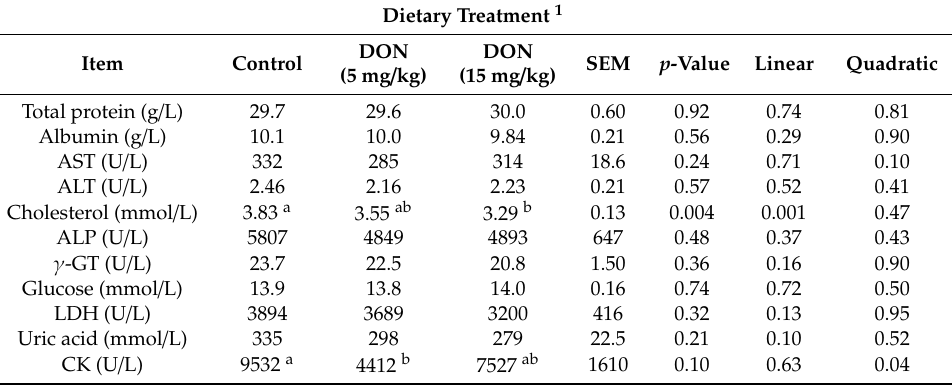
Table 6. E ff ects of DON-contaminated feed (5 and 15 mg / kg) on blood biochemistry of broiler chickens.